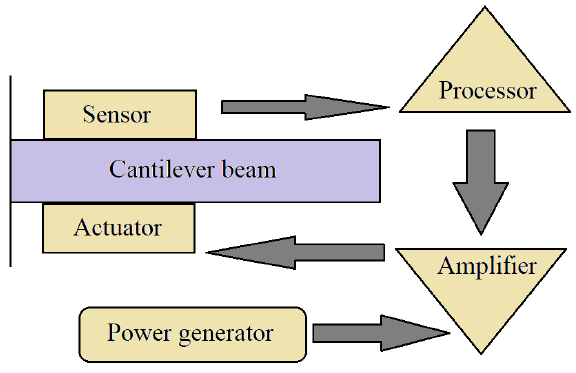
Figure 3. Schematic of a smart structure system